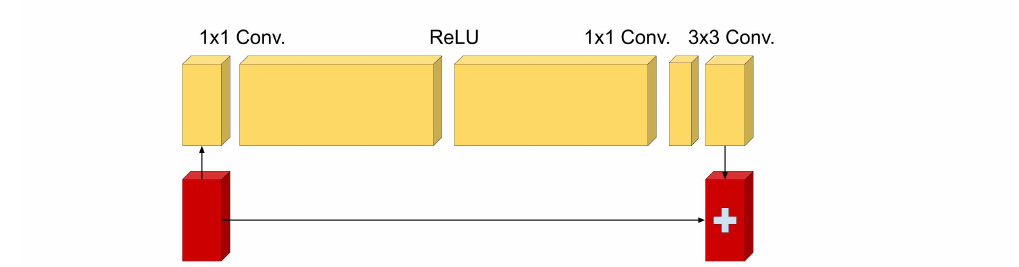
Figure 3. 2D-WDSR-bblock. The residual block is composed of a 1 × 1 Conv to expand features before ReLU activation. After activation, a 1 × 1 Conv followed by a 3 × 3 Conv are applied. 3D-WDSR-b used by our method follows the same approach, but taking into account the time